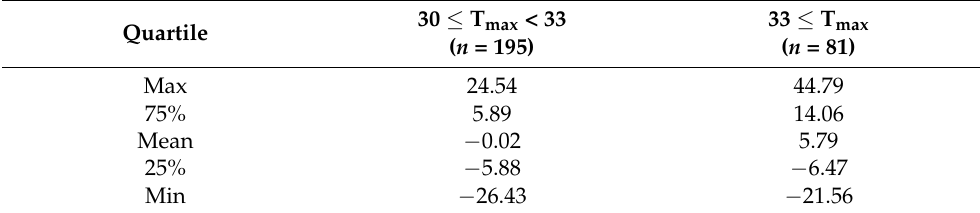
Table 2. Number of excess deaths per day by threshold temperature in